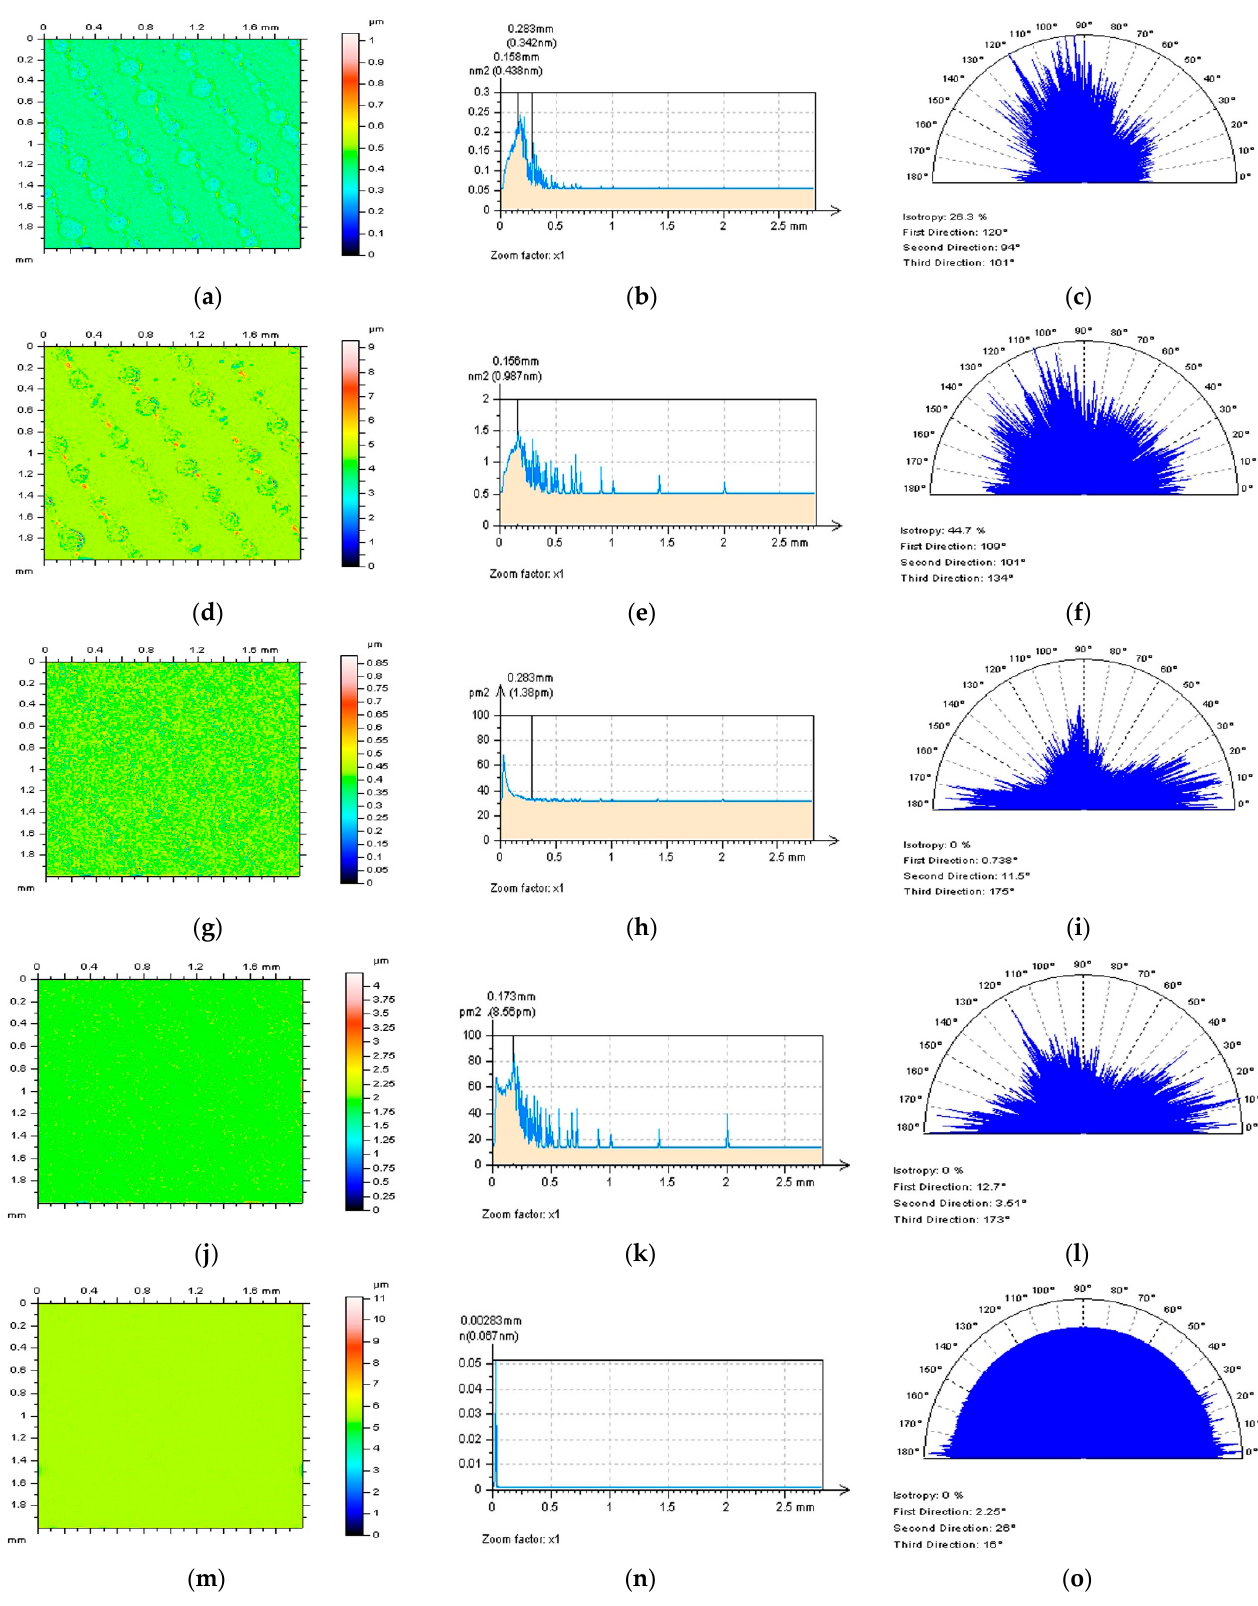
Figure 8. Analysis of a HFNS (left column), their PSDs (middle) and TDs (right column) received from a laser ‐ textured surface by filtering: GF ( a – c ), RGF ( d – f ), SF ( g – i ), MDF ( j – l ) and FFTF ( m – o ) approach, cut–off = 0.015 mm.